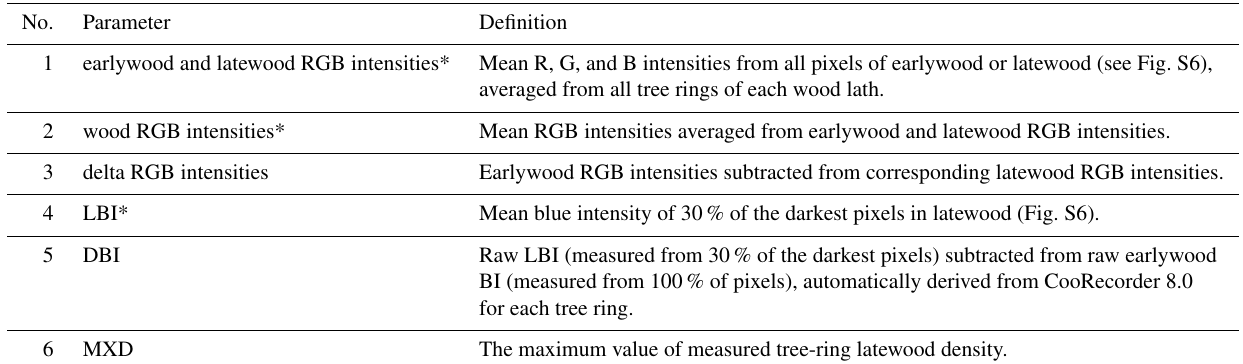
Table 2. Definitions of wood color intensities and tree-ring parameters used in this study. The RGB intensities refer to the color intensities measured separately for the red (R), green (G), and blue (B) channels. The parameters 1–3 are used to quantify wood colors, while the parameters 4–6 are conventional dendrochronological